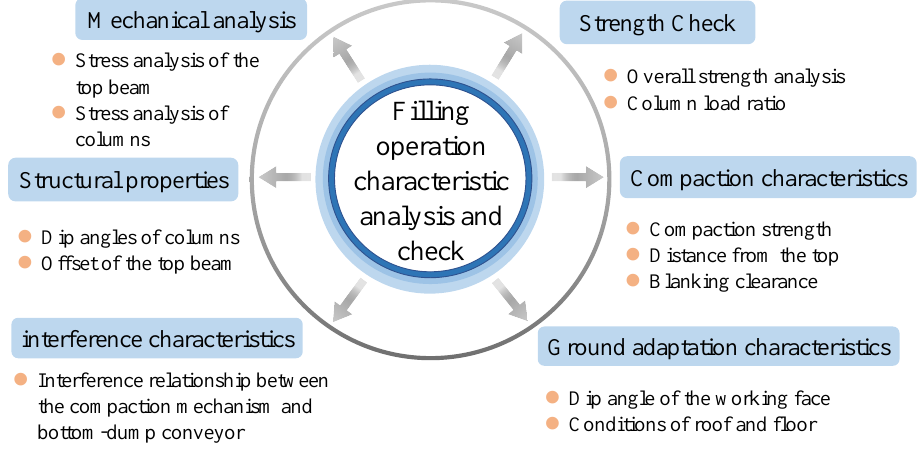
Figure 15. Backfilling characteristic indices.